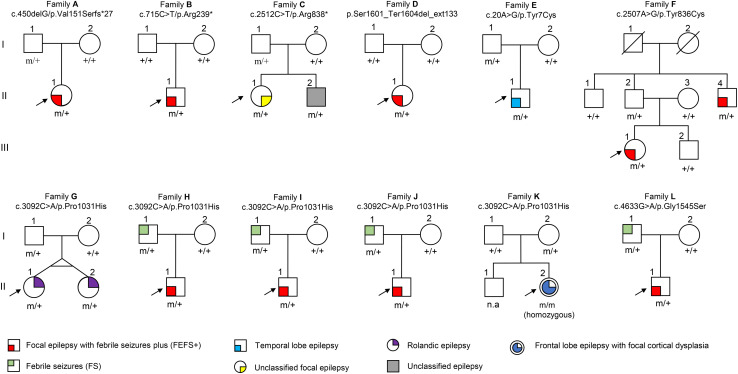
Pedigrees of the families with DEPDC5 mutations. Individuals with heterozygous mutation are indicated by m/+, those with homozygous mutation are indicated by m/m, and those negative for mutation are indicated by +/+. The probands are indicated by arrows. n.a., not available. The phenotype of each case is indicated by different symbols in the figure.